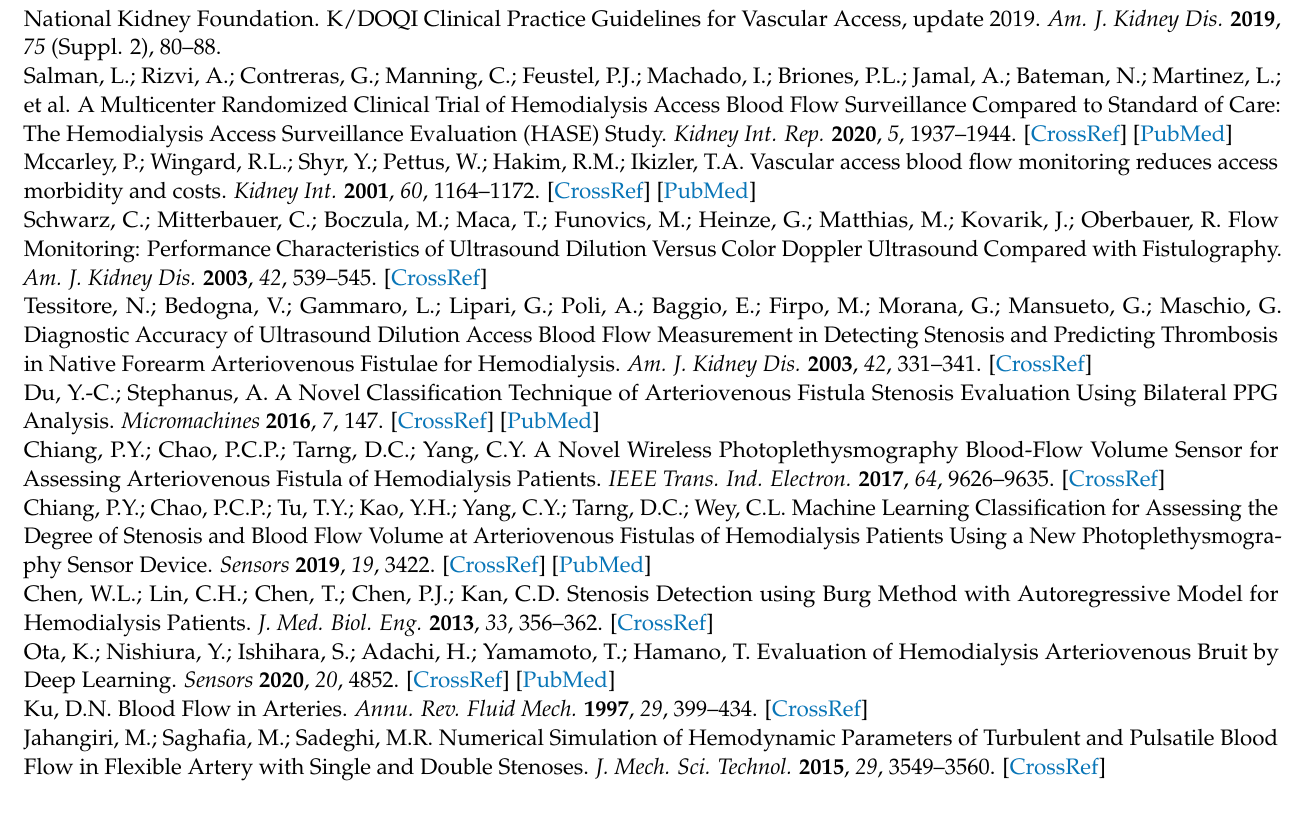
Figure A3. Attachment of the pulse radar sensor.